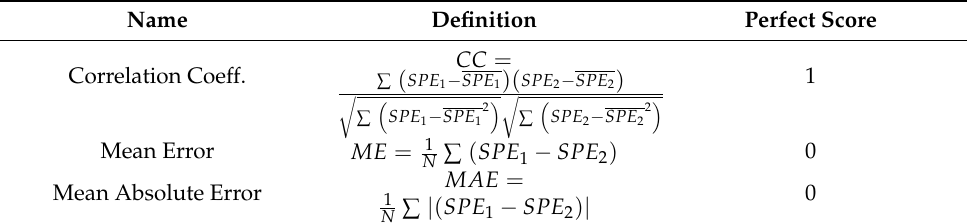
Table 2. Statistical parameters used for the quantitative